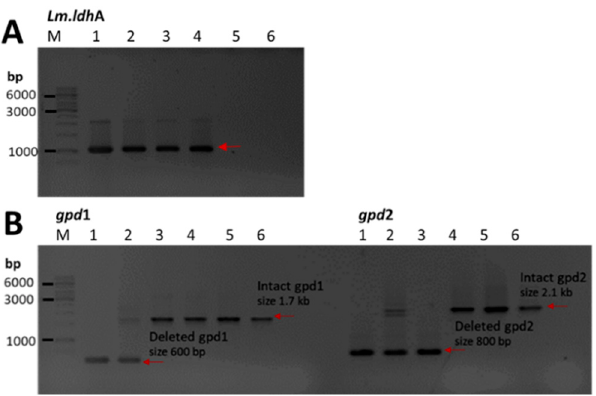
Figure 2. Construction of S. cerevisiae strains from yeast mating. ( A ) PCR amplification of Lm.ldhA gene (1kb) from the genomic DNA of the strain CEN.PK2_DLDH Δ gpd (lane 1), hybrid2 (lane 2), hybrid35 (lane 3), hybrid36 (lane 4), wild-type laboratory strain CEN.PK2-1C (lane 5), and wild isolate BCC39850 (lane 6). ( B ) PCR amplification of gpd genes ( gpd1 and gpd2 ; indicated above the lanes) from the genomic DNA of the strain CEN.PK2_DLDH Δ gpd (lane 1), hybrid2 (lane 2), hybrid35 (lane 3), hybrid36 (lane 4), wild-type laboratory strain CEN.PK2-1C (lane 5), and wild isolate BCC39850 (lane 6). The products from PCR amplification were separated by agarose gel electrophoresis and stained with ethidium bromide. Sizes of PCR amplicons were estimated by comparison with DNA markers (lanes marked M), in which fragments of known length are indicated on the left.